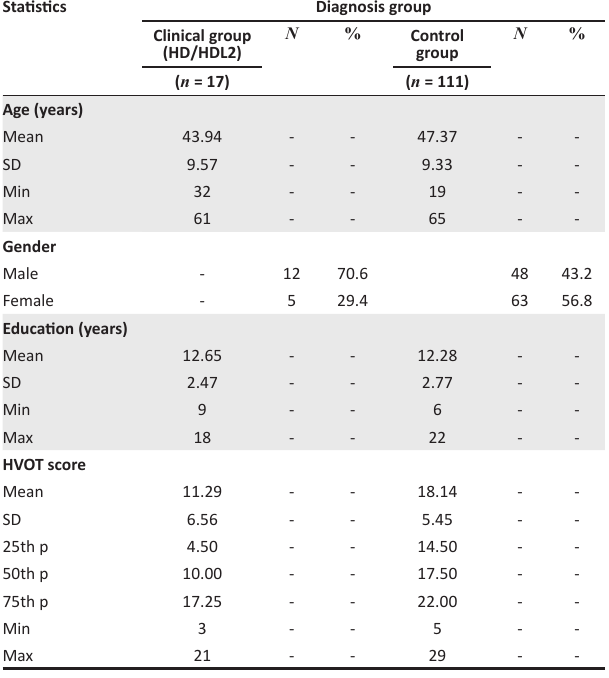
TABLE 1: Demographic characteristics of the clinical (HD/HDL2) and control